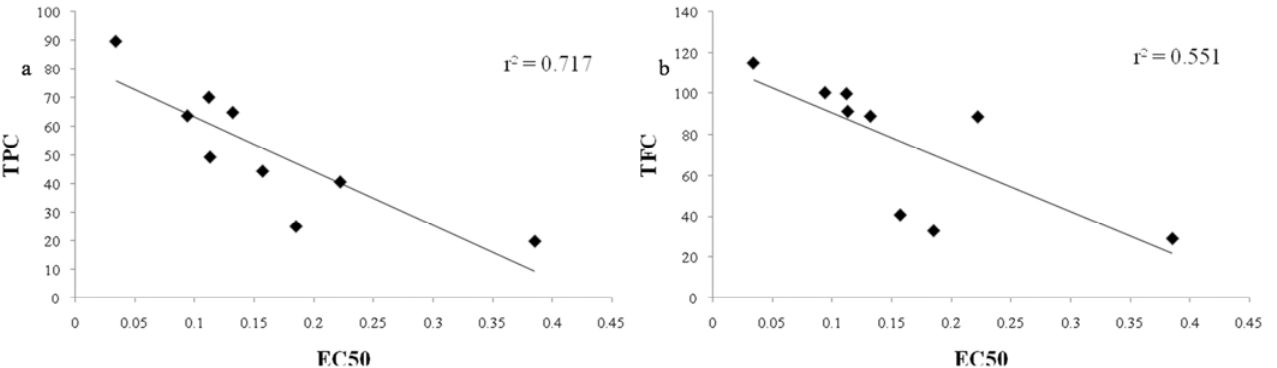
Figure 2. ( a ) Correlation of total phenolic content (TPC) and EC leaves extracts; ( b ) Correlation of total flavonoid content (TFC) and EC leaves